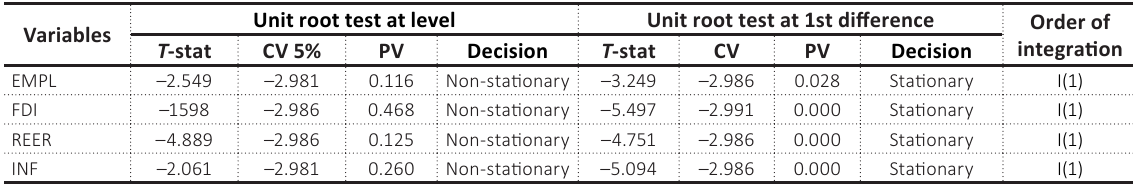
Table 2. Stationary test using Phillips-Perron